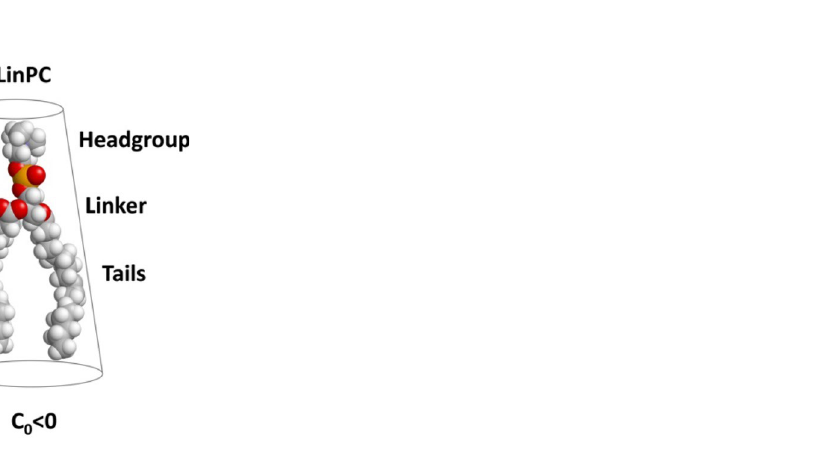
Figure 6. Effect of increased tail unsaturation on lipid molecular shape. The additional cis double bond in the linoleoyl tails induces a kink in the tails that is not readily offset by gauche conformations of single bonds in the chain. The linoleoyl tails therefore take up a greater lateral area. This changes the molecular shape, resulting in a different spontaneous curvature ( C 0 < 0) and thinning of the bilayer. The 3D chemical structures were rendered using RasTop 2.2 (https:// www. genei nfini ty. org/